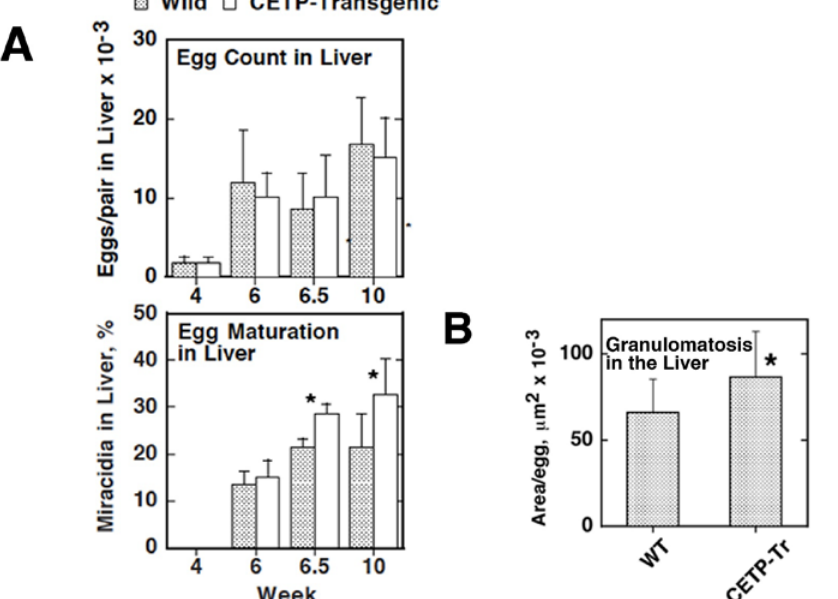
Figure 7. Egg embryonation and the liver lesion development in the wild-type and CETP-transgenic mice infected with S. japonicum . ( A ): Number of the eggs embolizing in the liver and ectopic embryonation of the eggs counted microscopically; ( B ): Granulomatosis lesion in the liver. The eggs and granulomatous lesions were identified microscopically in the liver specimens. The total area of the lesion per egg was calculated for each section. The area per egg was calculated as an average ± SE of the 12 mice, for each of which 12 random liver sections were examined. Asterisks indicate difference at p < 0.05 from the wild type